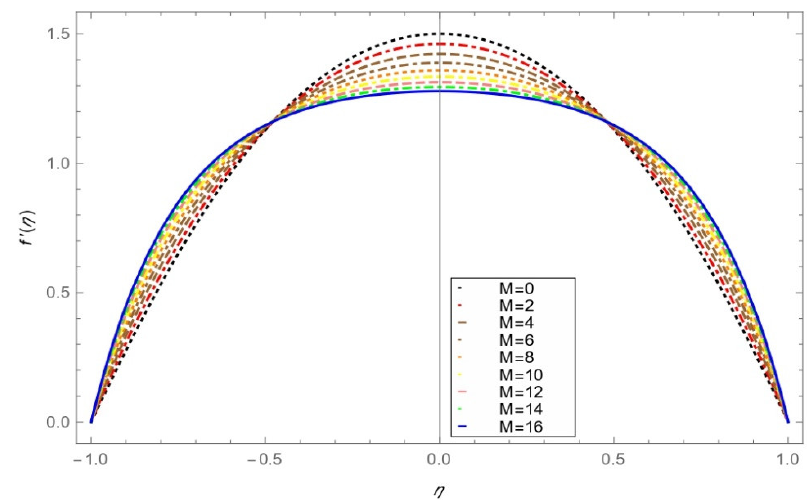
Figure 11. Radial velocity profile effect of the magnetic parameter for α = 1, Re = 1, ϕ 1 = ϕ 2 = 0.01, Pr = 6.2.